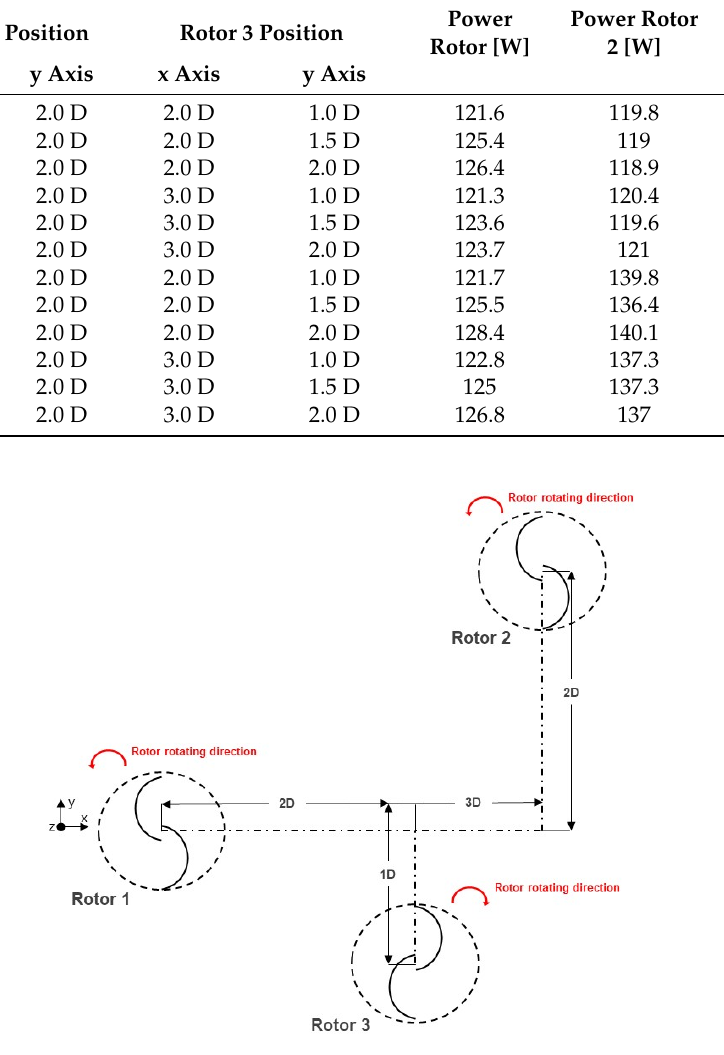
Figure 15. Arrangement spacing and rotation directions of three rotors in case 1.